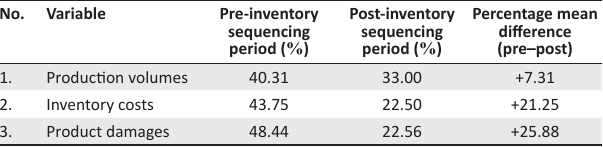
TABLE 2: Pre- and post-inventory sequencing percentage means variable comparisons.